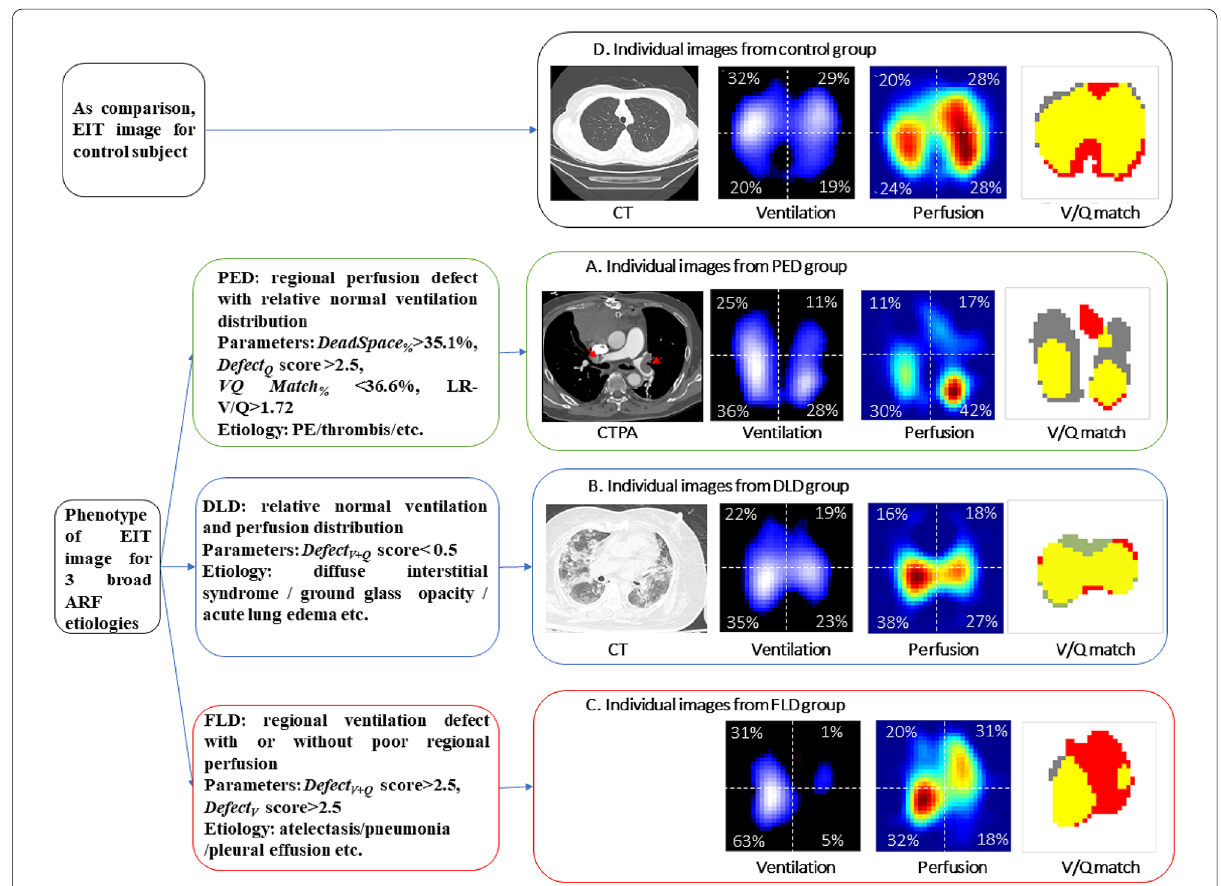
Fig. 4 Phenotype of ventilation/perfusion and individual images by EIT for the three broad ARF etiologies. The control group was postoperative ICU patients without acute respiratory failure; PED group: patients with pulmonary embolism-related disease; DLD group: patients with diffuse lung involvement disease; FLD group: patients with focal lung involvement disease. A Patient from the PED group (CTPA: demonstrated large embolism in both left and right main pulmonary arteries. Ventilation image: upper right (UR) 25%, upper left (UL) 11%, lower right (LR) 36%, lower left (LL) 28% (% denoted the ventilation distribution), Defect V score was 1. Low ventilated regions are marked in dark blue and high ventilated regions in light blue to white. Perfusion image: upper right (UR) 11%, upper left (UL) 17%, lower right (LR) 30%, lower left (LL) 43%, Defect Q score was 1. Regions with high perfusion are marked in red and low perfusion in green. V / Q match image: percentage of Shunt % area in red was 10% of the lung regions, DeadSpace % area in grey 46%, and VQMatch % region in yellow 43%. (partially adapted from our recent case report [47]). B A patient with ground glass opacity from the DLD group (CT: diffuse opacities in both lungs. Ventilation image: UR 2%, UL 19%, LR 35%, LL 23%, Defect V score was 0. Perfusion image: UR 16%, UL 18%, LR 38%, LL 27%, Defect Q score was 0. V / Q match image: Shunt % 6%, DeadSpace % 15%, and VQMatch % 78% (partially adapted from our previous study with permission of the American Thoracic Society. Copyright © 2020 American Thoracic Society [16]. All rights reserved). C A patient with acute left lung atelectasis from the FLD group (ventilation image: UR 31%, UL 1%, LR 63%, LL 5%, ventilation-defect score was 4. Perfusion image: UR 20%, UL 31%, LR32%, LL 18%, Defect Q score was 0. V / Q match image: Shunt % 55%, DeadSpace % 3%, and VQMatch % 42%). D A patient from the control group. Percentage of intrapulmonary shunt area in red was 17%, dead-space fraction area in grey 5%, and VQMatch % region in yellow 78%. Defect V and Defect Q scores were